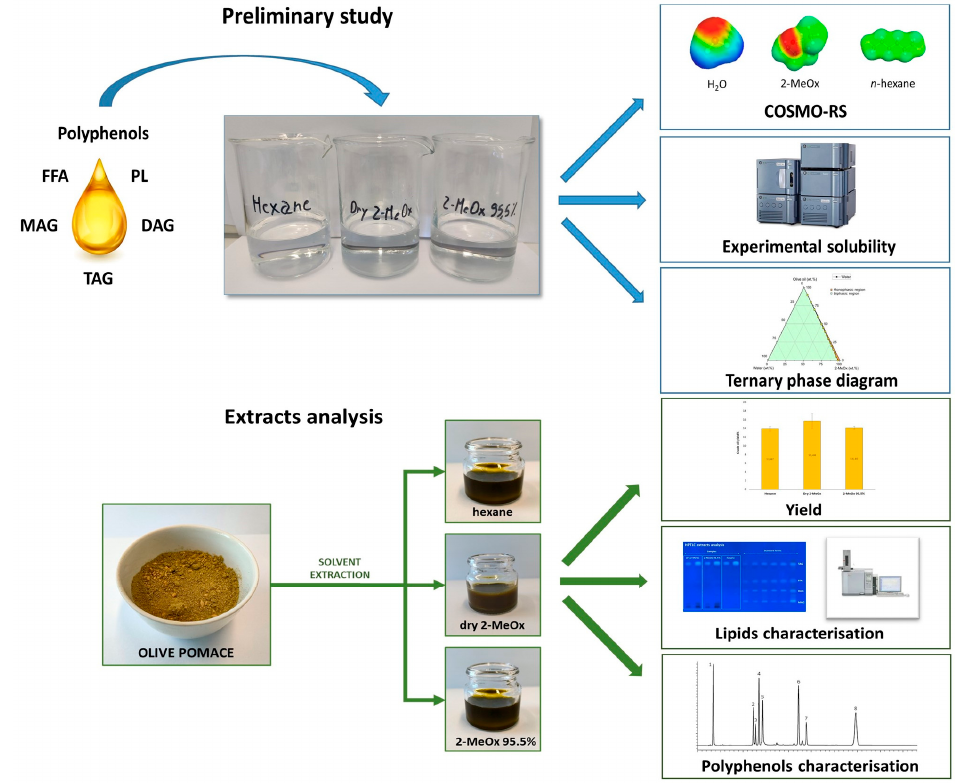
Figure 3. Study design overview.